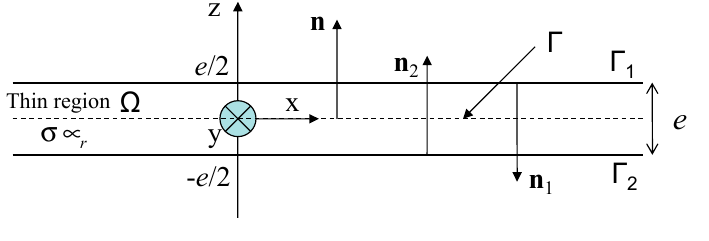
Figure 1. Thin region and associated notations [16].